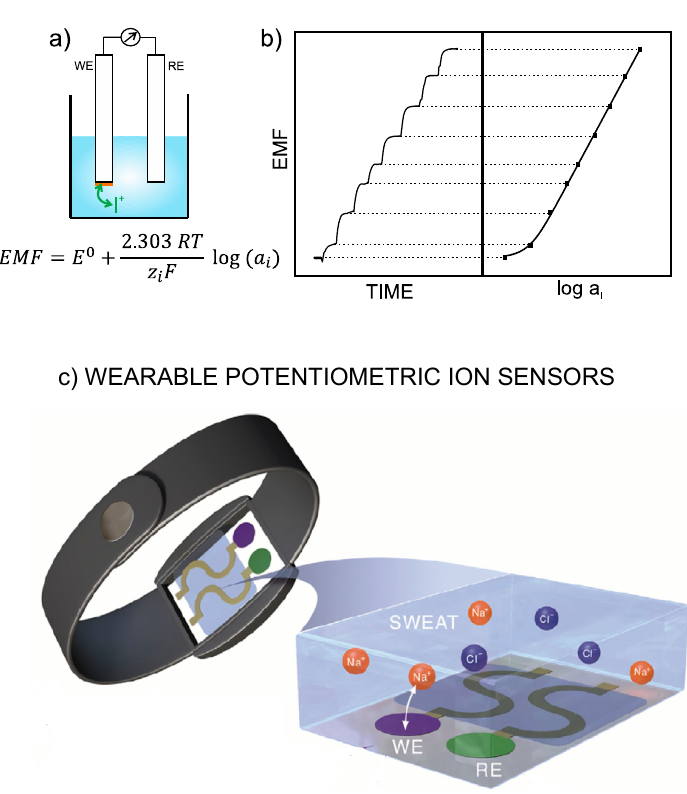
Figure 1. ( a ) Illustration of a general electrochemical cell based on a potentiometric electrode